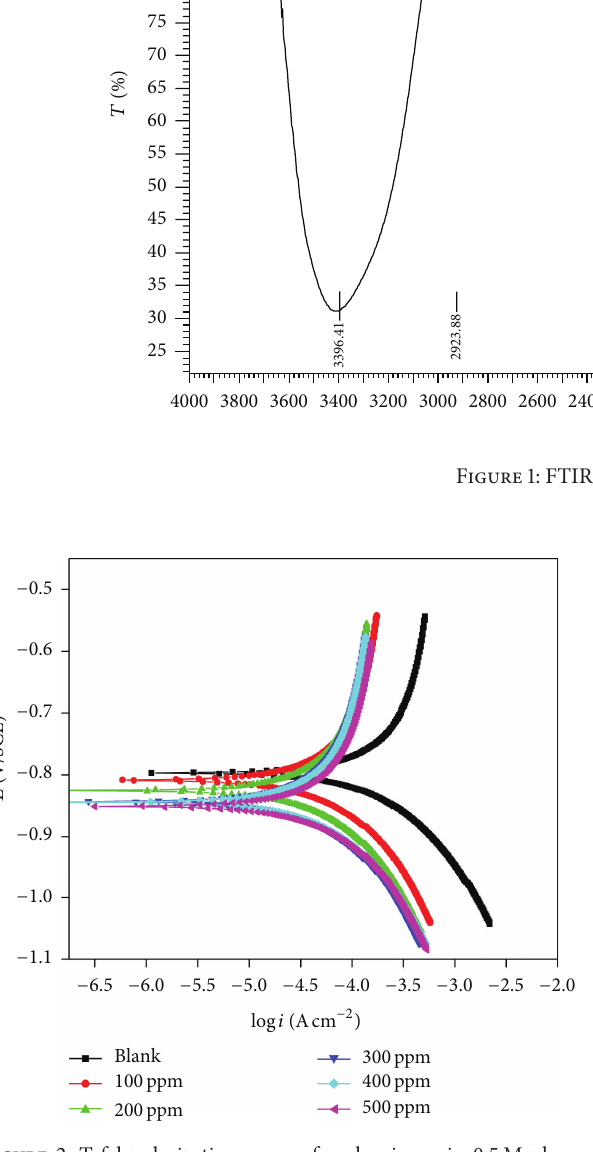
Figure 2: Tafel polarization curves for aluminum in 0.5M phos- phoric acid solution at different concentrations of inhibitor (CSE) at 30 ∘